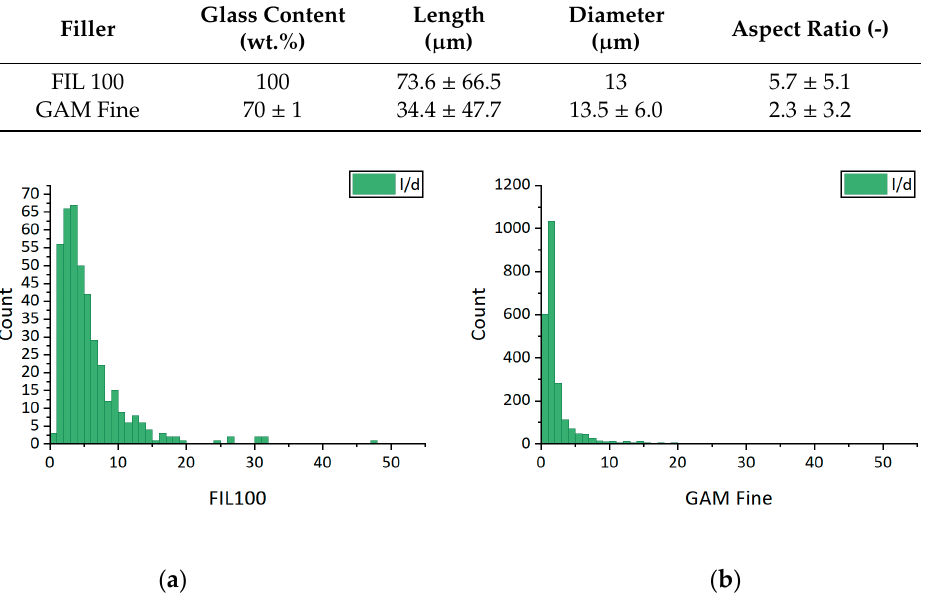
Figure 3. Glass fiber aspect ratio distribution graphs of: ( a ) of FIL 100 virgin glass fibers; ( b ) GAM Fine glass fiber recyclate.